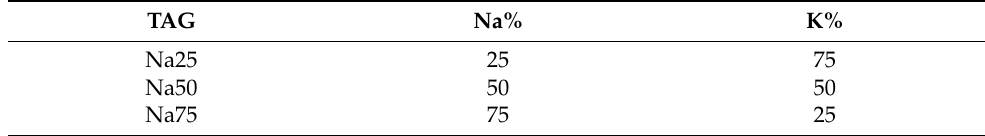
Table 1. Nomenclature for the composition of alkali mixtures in alkaline solution. TAG Na% K% Na25 25 75 Na50 50 50 Na75